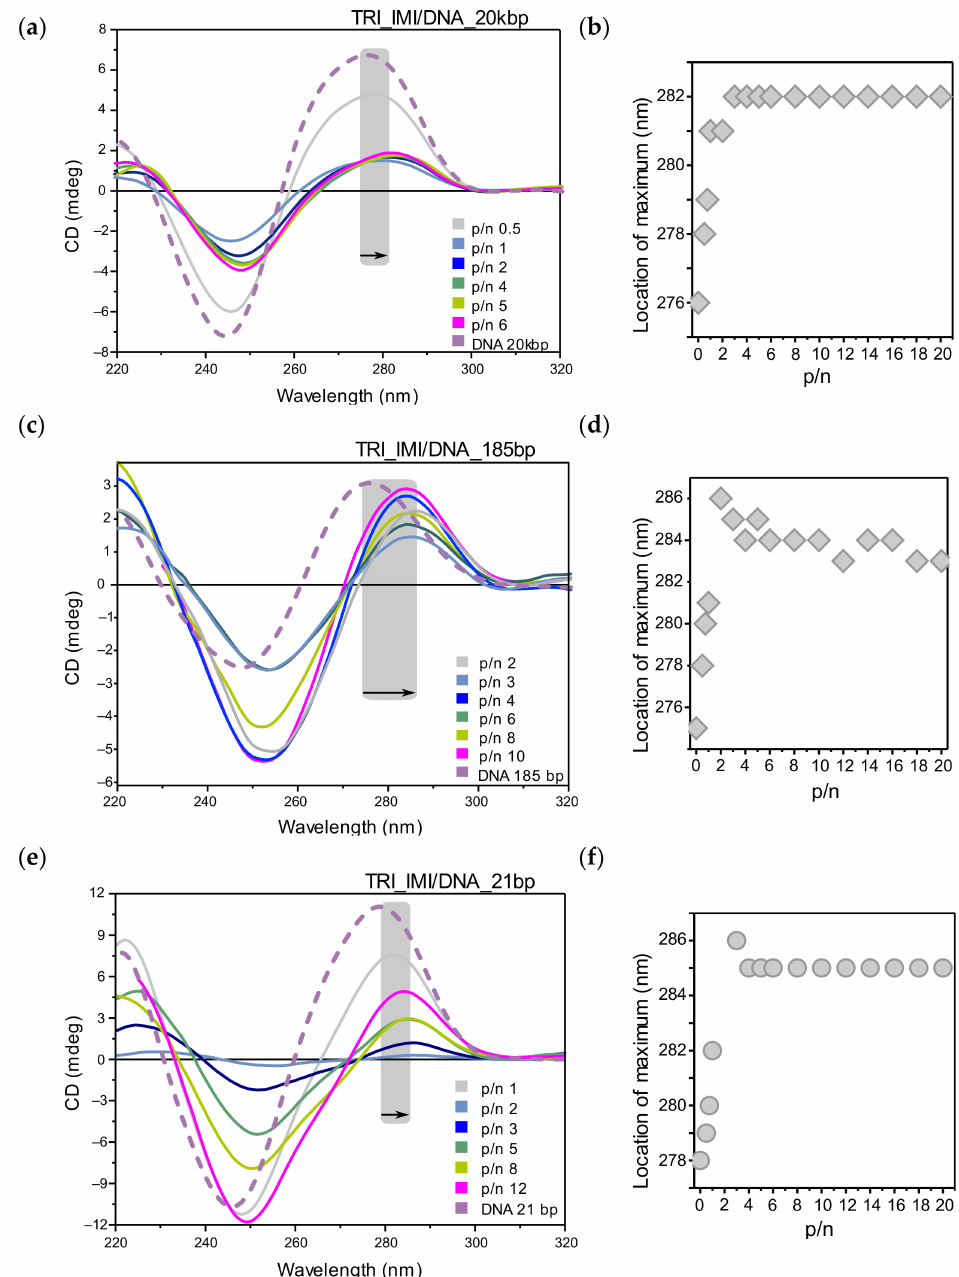
Figure 6. Circular dichroism studies of TRI_IMI surfactant with different DNAs. ( a ) CD spectra collected for TRI_IMI/DNA_20kbp systems and ( b ) corresponding shifts of positive maximum with increasing p/n ratio. ( c ) CD spectra collected for TRI_IMI/DNA_185bp systems and ( d ) corresponding shifts of positive maximum with increasing p/n ratio. ( e ) CD spec- tra collected for TRI_IMI/DNA_21bp systems and ( f ) corresponding shifts of positive maximum with increasing p/n